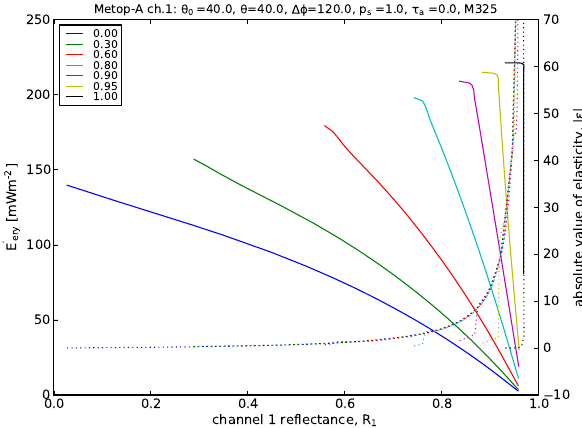
Figure 9. The dependence of the erythemal dose rate on the channel 1 reflectance for different surface albedos derived from data shown in Figs. 4 and 5 (solid lines, left y axis) together with the elastic- ity (dashed lines, right y axis) indicating the percent change in the dose rate with respect to a percent change in channel 1 reflectance. Symbols are defined in Table